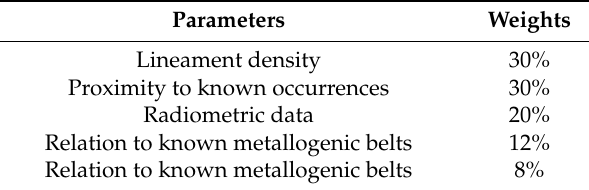
Table 4. Parameters and weights used for the ranking of selected